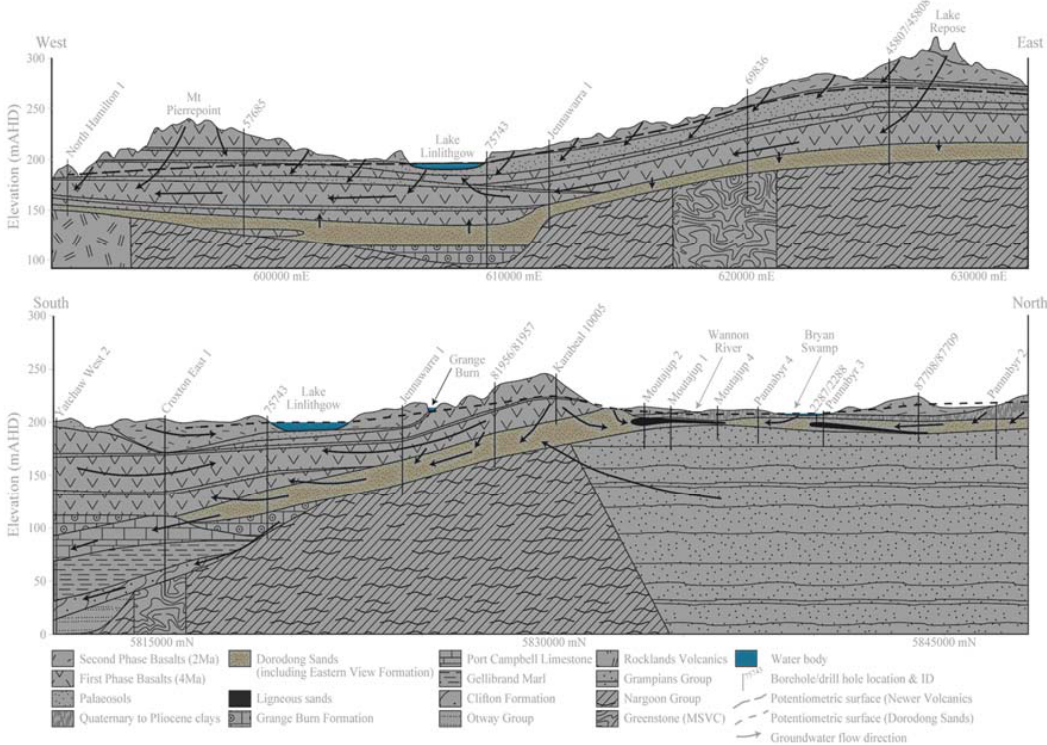
Figure 6. West–East and South–North hydrogeological cross sections through Lake Linlithgow [50,55].